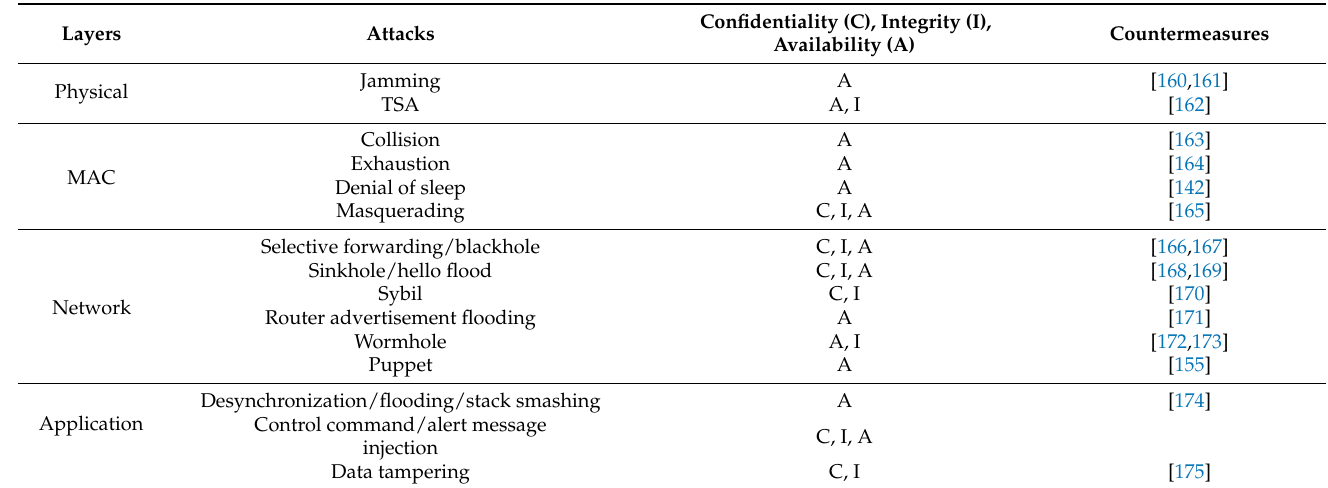
Table 3. Attacks by OSI